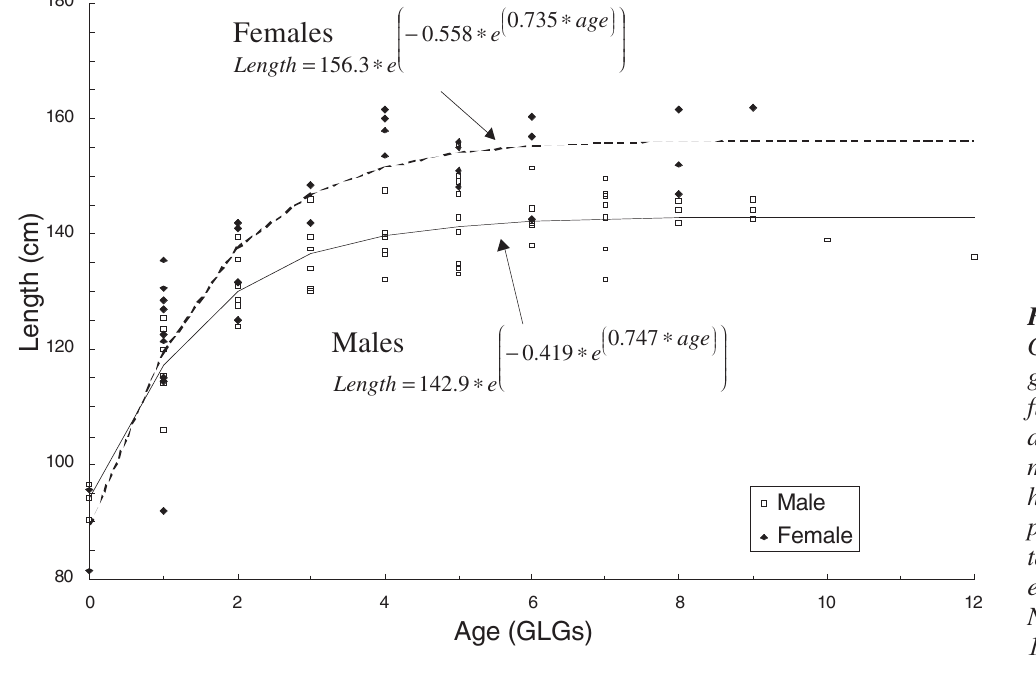
Fig. 1: Gompertz growth curves fit to length at age data for male and female harbour por- poises inciden- tally caught in eastern